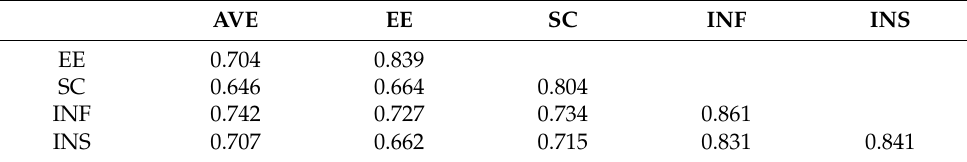
Table 4. Results of the convergent and discriminant validity of the